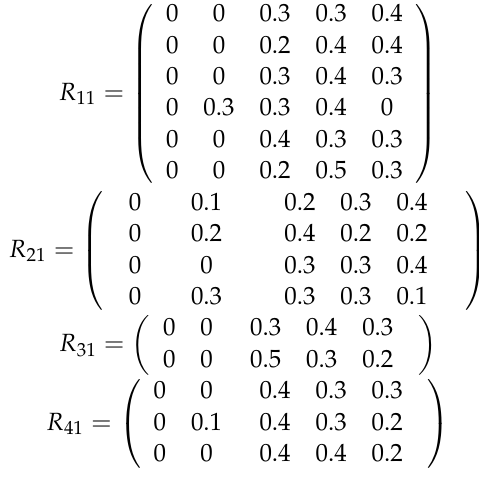
Figure 6. The risk grades of four criteria and the comprehensive risk